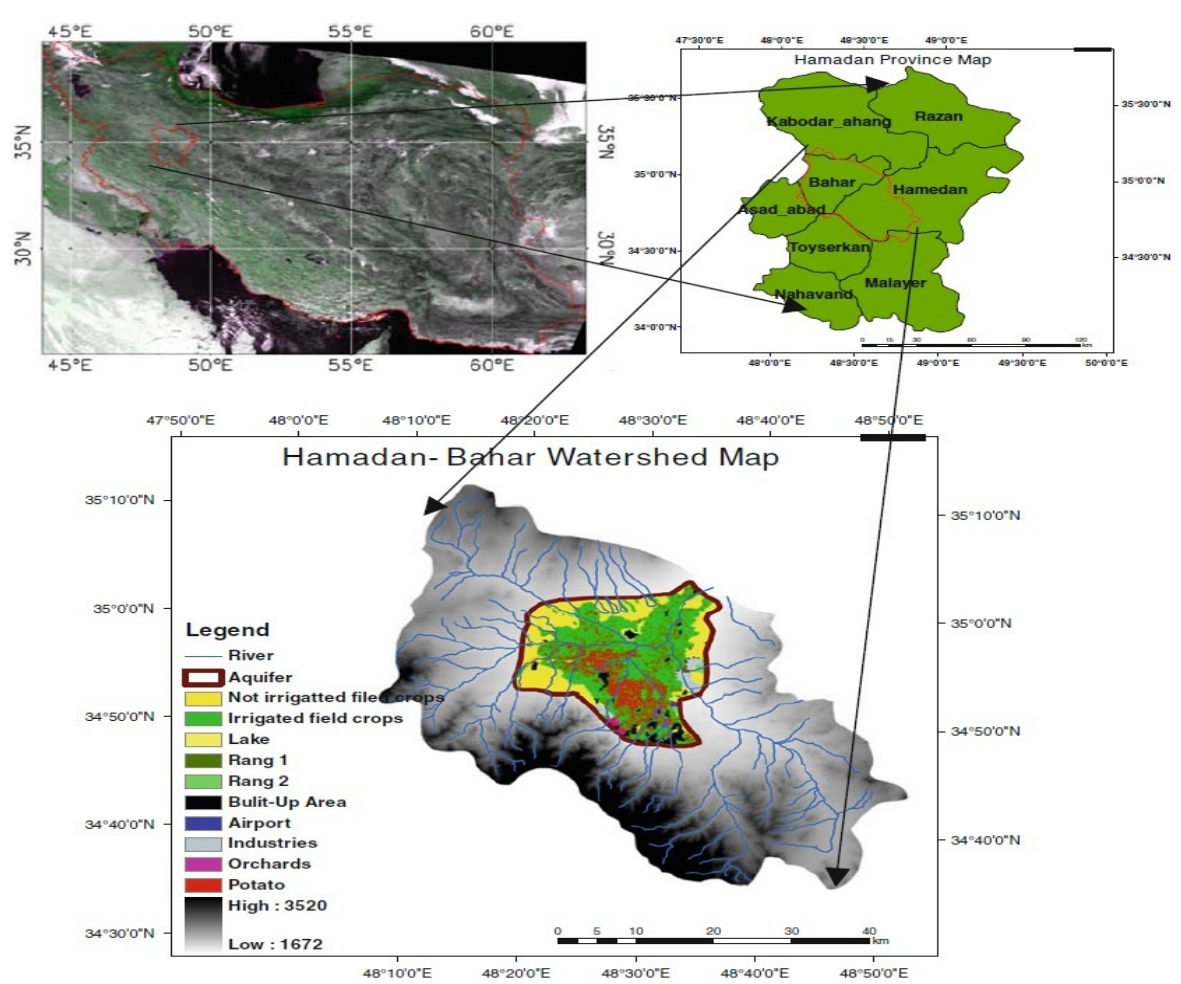
Figure 1. Location of study area of Hamedan-Bahar Plain, Hamedan Province, Iran